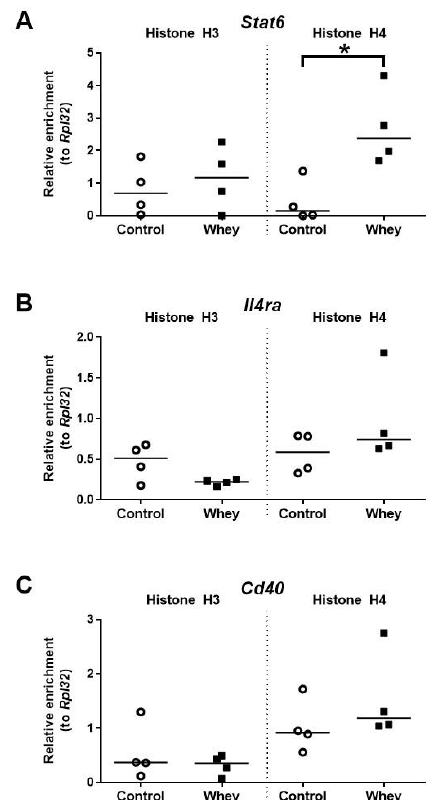
Figure 7. A confirmed allergic response to whey protein increased H4 histone acetylation levels at the promotor of Stat6 but had no effect on other allergy-related B cell genes. Histone acetylation levels at the signal transducer and activator of transcription 6 gene ( Stat6 ) ( A ), the interleukin 4 receptor alpha gene ( Il4ra ) ( B ), and the CD40 antigen gene ( Cd40 ) ( C ) in spleen-derived B cells as determined by chromatin immunoprecipitation followed by qPCR. Data are presented as scatter dot plots showing individual data points with median. Comparisons were performed with Mann–Whitney U-test; * p < 0.05.